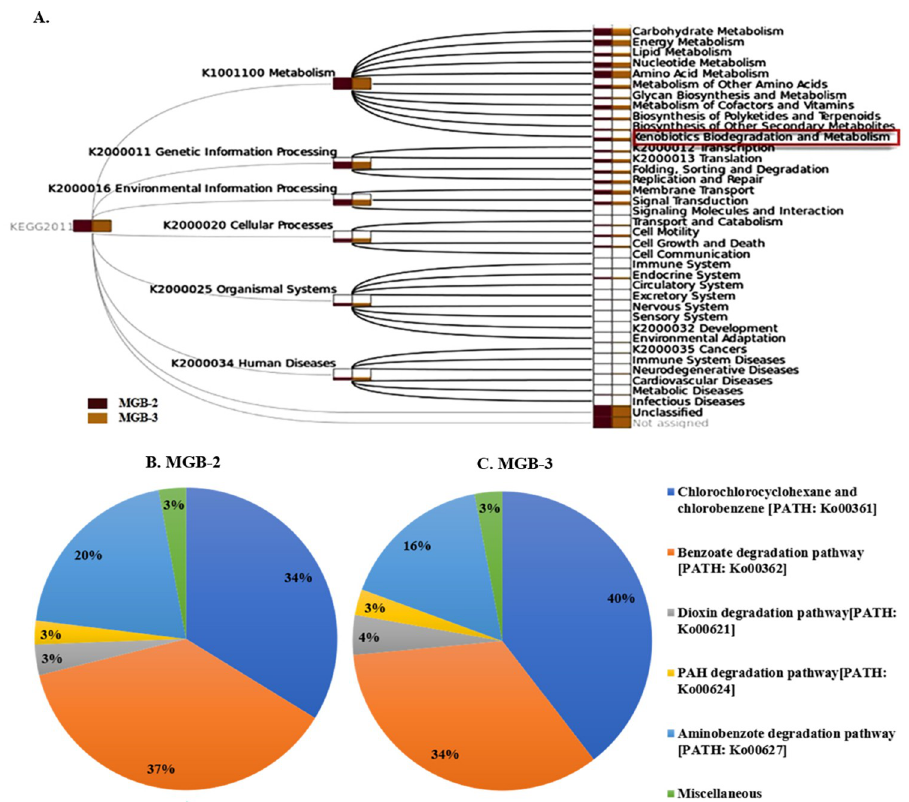
Fig 4. SEED subsystem analysis in MG-RAST assigned reads in MGB-2 and MGB-3 based on various (A) functions (B) Xenobiotic biodegradation pathways.